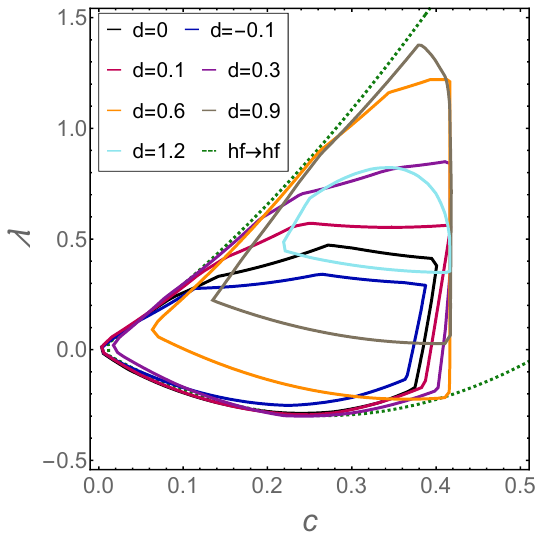
Figure 2 . Positive regions in the ( c, λ ) -plane for different d with κ 3 = 1 . 4 , κ 4 = 0 . 36 (the regions within the solid lines are allowed by generalized elastic positivity bounds) in the Z The green dashed line is the positivity bound from elastic scattering hf → hf . We see that the positive cross section changes dramatically with d in this